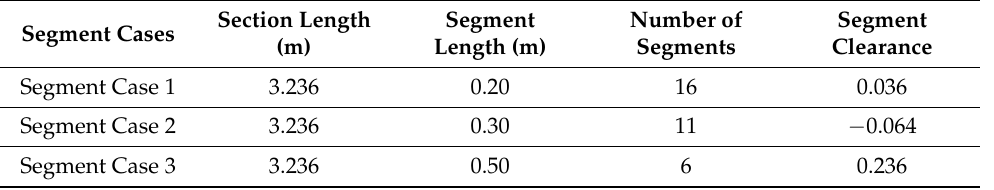
Table 15. Segment Cases for Hose Segment